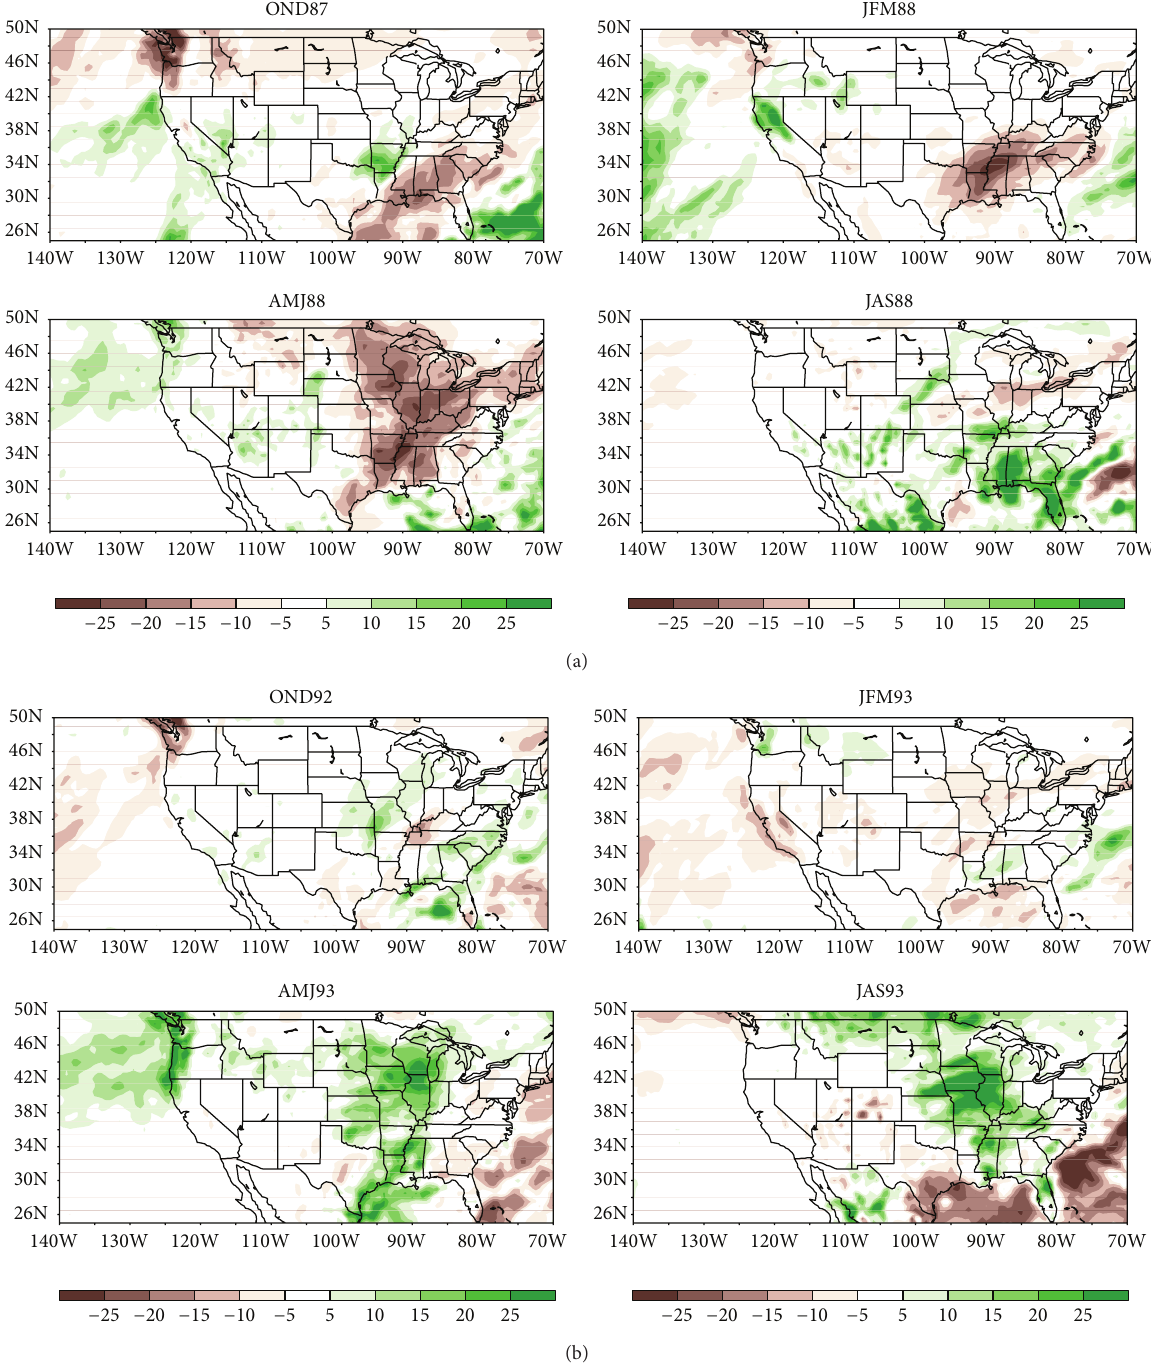
Figure 3: Seasonal precipitation departures from normal (mm) from CFSR data for (a) OND87 through JAS88 and (b) OND92 through JAS93. Seasonal normal taken relative to